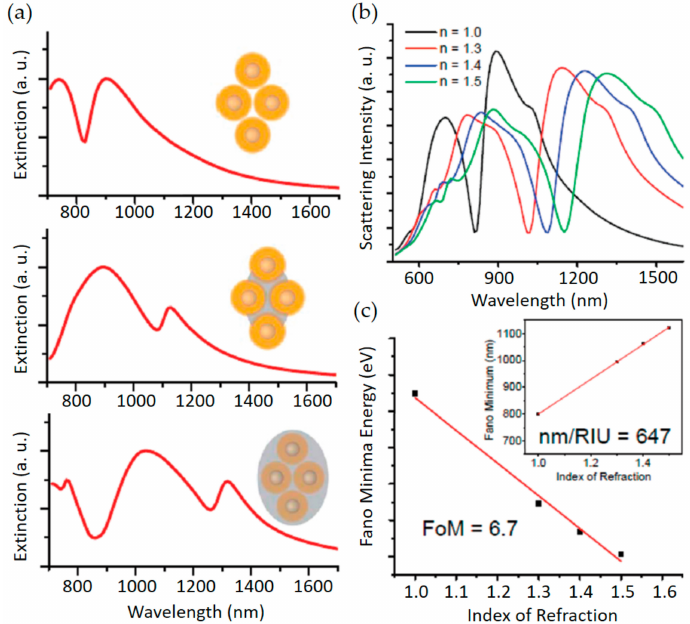
Figure 5. Calculated spectra of quadrumers in different dielectric environments. ( a ) The dip of Fano resonance is highly sensitive to the surrounding; ( b ) Scattering spectra of a quadrumer embedded in environments of different index of refraction; ( c ) The calculated figure of merit. The inset shows the calculated sensitivity to be 647 nm/RIU. Reprinted with permission from Reference [94]. Copyright (2010) American Chemical